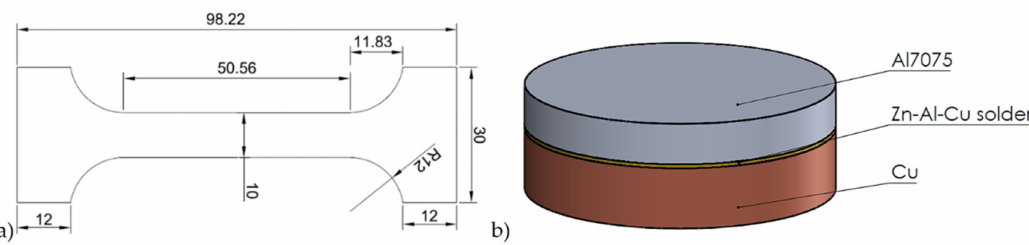
Figure 1. Schematic presentation of test pieces (unit: mm). ( a ) Tensile strength test piece; ( b ) assembly of soldered